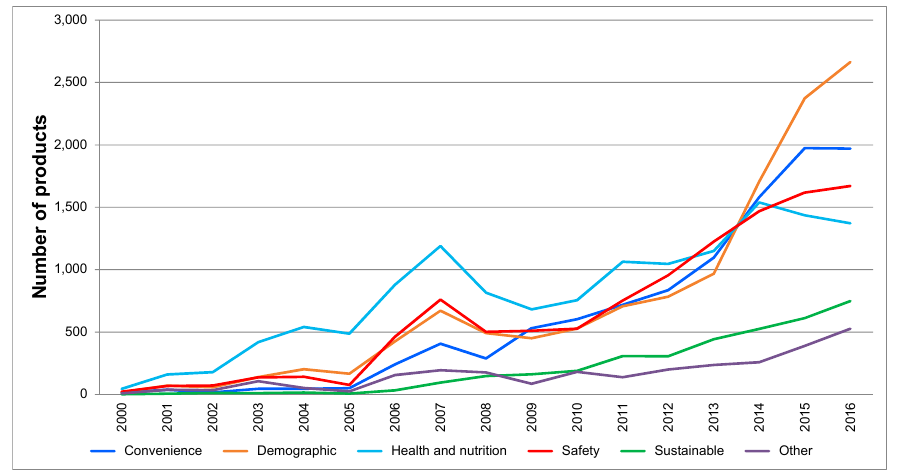
Figure 4. Number of launched products by claim group during 2000–2016. Source: Own elaboration based on Mintel’s GNPD data.